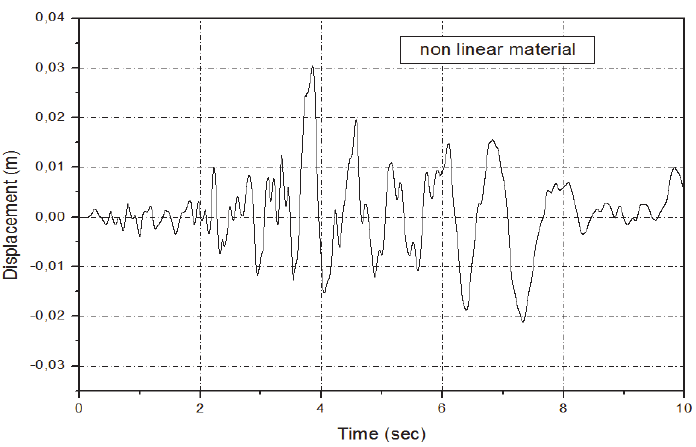
Figure 5: Horizontal displacements at the crest of the dam